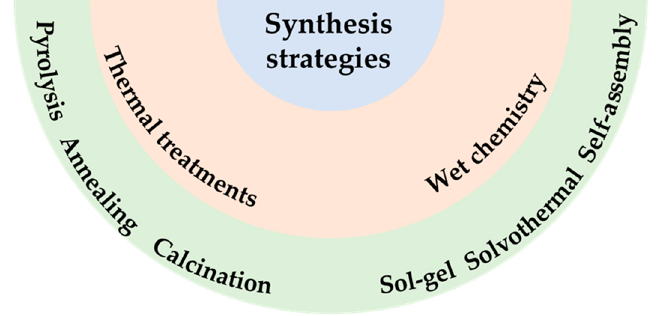
Figure 3. Main Synthesis Methods to realize hierarchical nanostructures.